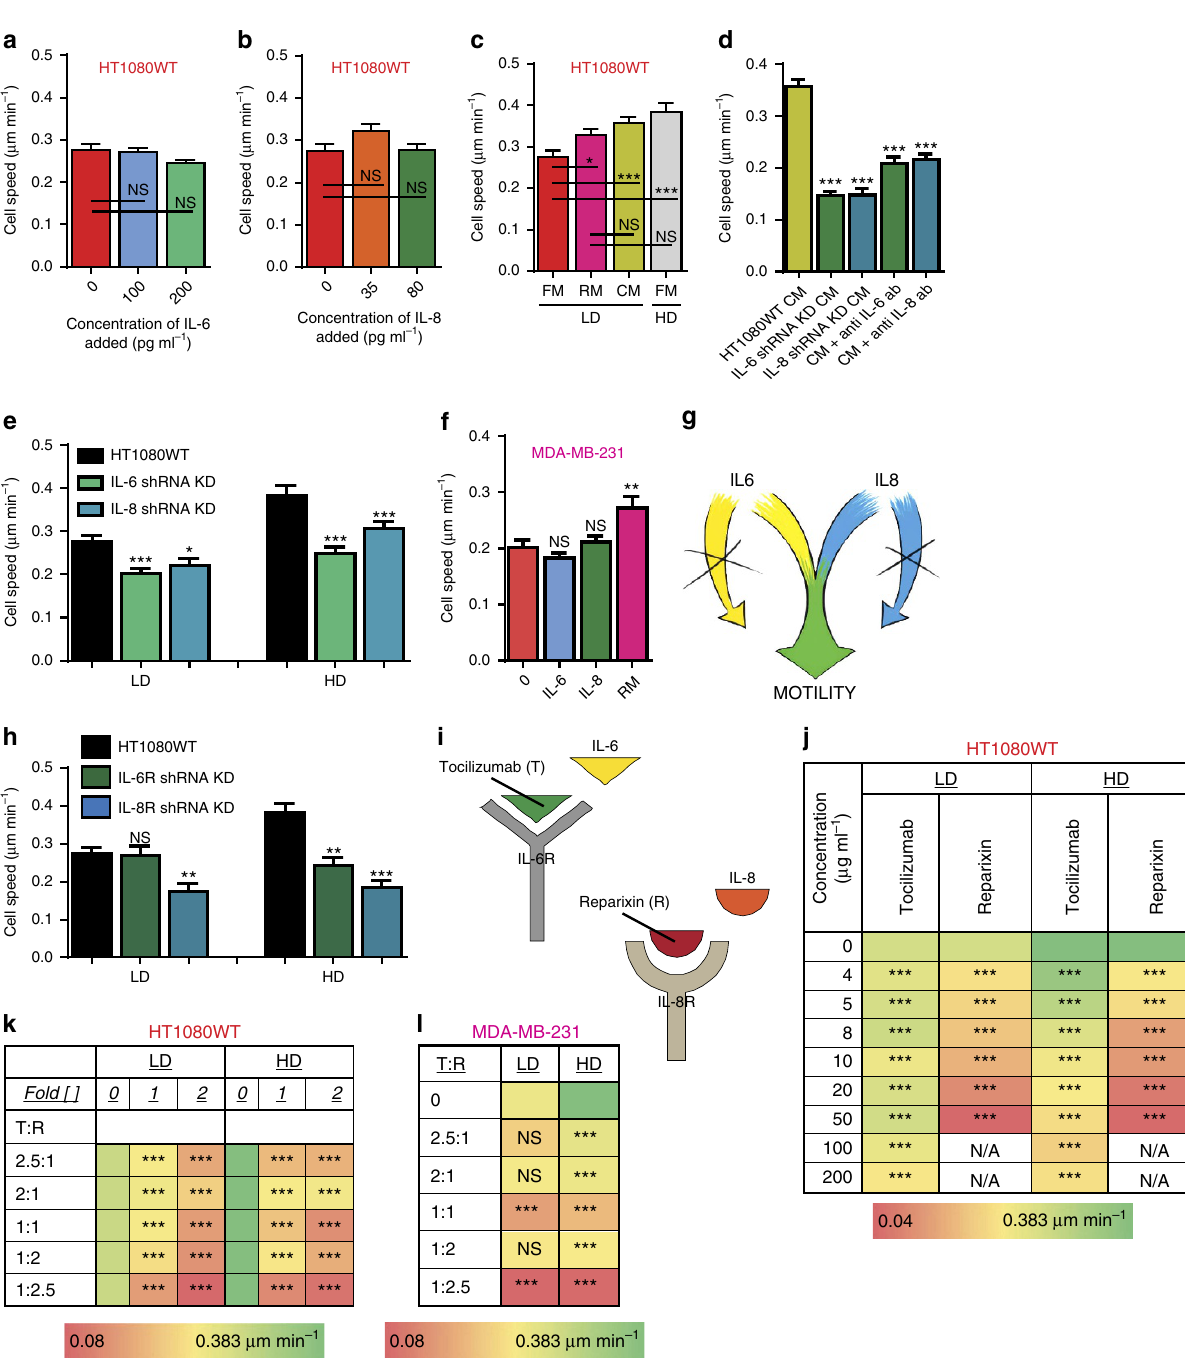
Figure 3 | Functional influence of IL-6 and IL-8. ( a , b ) The addition of recombinant IL-6 alone or recombinant IL-8 alone do not increase cell speed. ( c )